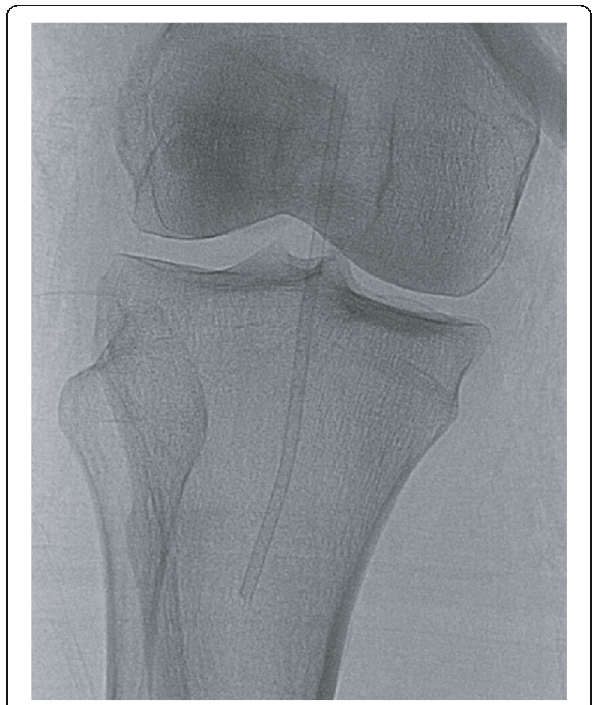
Fig. 5 Fluoroscopic image showing the migrated position of the sheath fragment extending from the popliteal artery into the tibioperoneal trunk